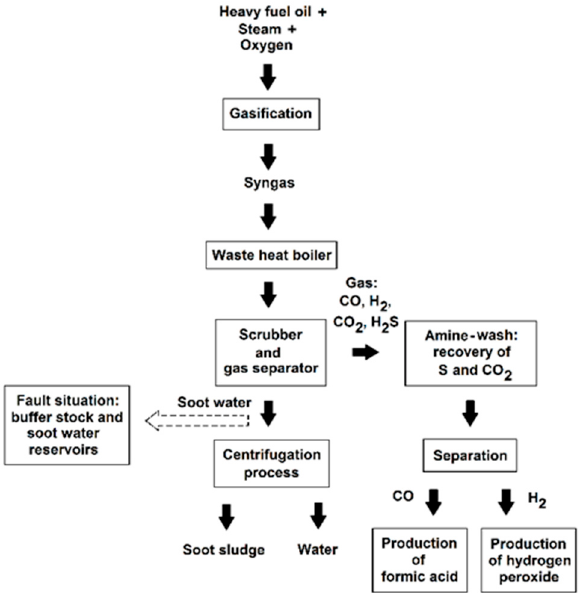
Figure 1. Formation process of the soot sludge (Reproduced from [5]. Illustration is based on the text in [26]).